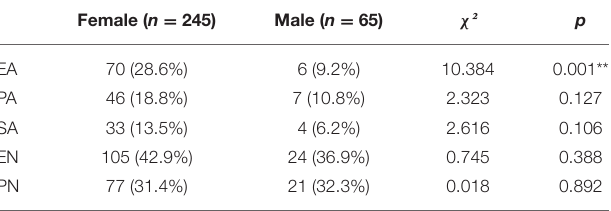
TABLE 2 | Prevalence of five childhood traumas in different